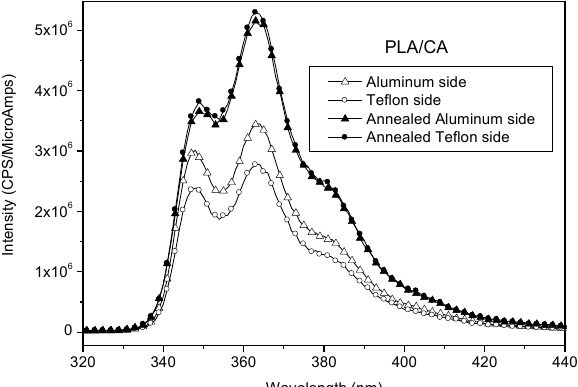
Figure 11. Fluorescence emission spectra collected from PLA/CA before and after annealing from the aluminum and Teflon sides.